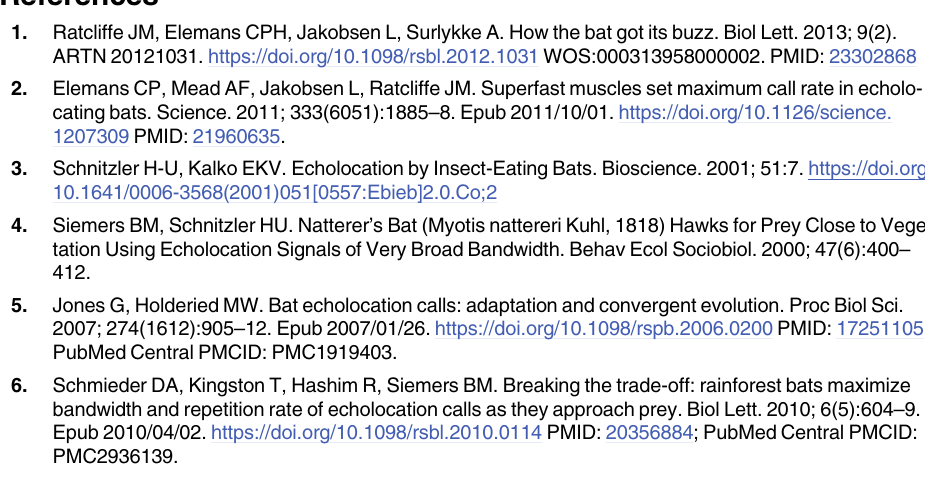
range in vitro, ventricular o